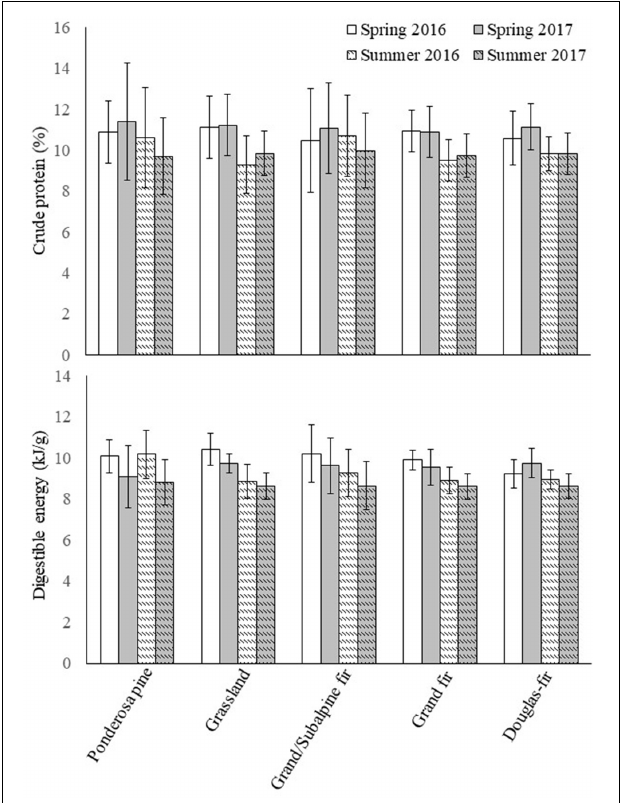
FIGURE 3 | Mean ( ± 90% CI) values of crude protein (%) and digestible energy (kJ/g) in selected and neutral forage plants combined at transects sampled within each potential vegetation type during spring (13 May–30 June) and summer (1 July–11 August), 2016 and 2017, at the Starkey Experimental Forest and Range, Oregon, United States.